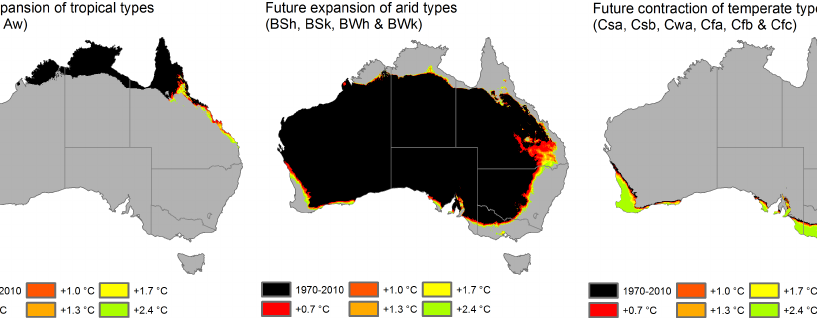
Fig. 5. Future extents of the top level K¨oppen-Geiger classification – arid, tropical and temperate (cold not shown on this